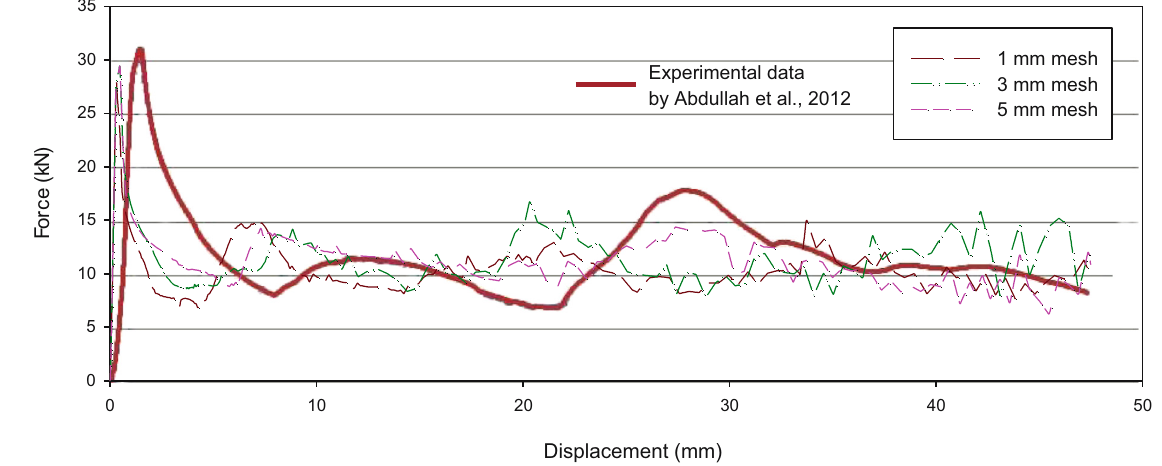
Figure 2: Comparison of the force versus displacement curve between experimental data and